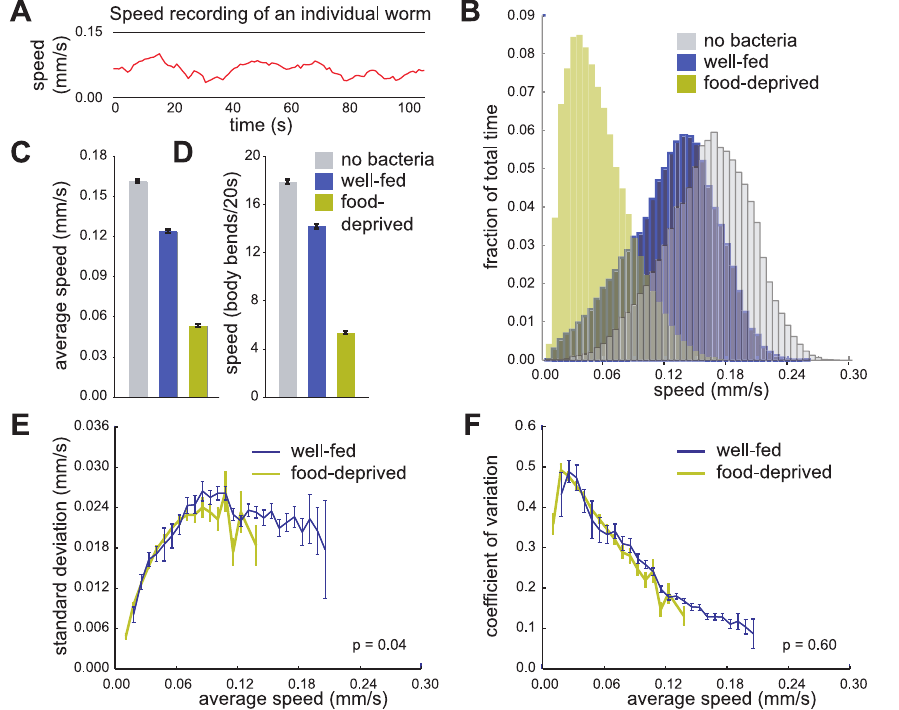
Figure 1. Wild-type C.elegans locomotion assayed using an automated locomotion tracking system. (A) A speed recording of an individual worm. (B) Frequency distributions of instantaneous speed recordings of animals in the off-bacteria, well-fed on-bacteria, and food-deprived on-bacteria conditions. Each bin is 0.006 mm/sec wide. (C) Average speeds of animals in each condition. (D) Average speeds of animals as measured by manually counting body bends over 20 sec intervals. Average (E) standard deviations and (F) coefficients of variation of speed measurements within individual tracks for well-fed and food-deprived animals. p-values for differences between well-fed and food-deprived data curves were calculated using two-way ANOVA. Tracks were first grouped by average speed. Each bin is 0.0075 mm/sec wide. Error bars, SEM. (B, C, E, F: n=1510 off-food, 1174 well-fed, 967 food-deprived animal tracks, mean track length was 53 sec in the automated assay; D: n=528 off-food, 508 well-fed, 642 food-deprived animals assayed